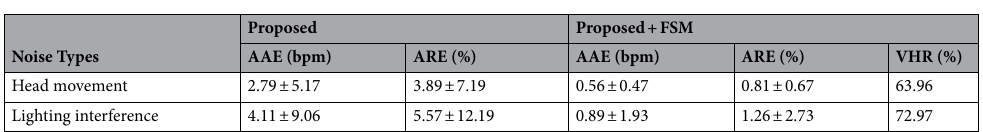
Table 4. HR estimation performance comparison between the proposed method and the FSM method according to the noise type. Values are reported as means ± standard